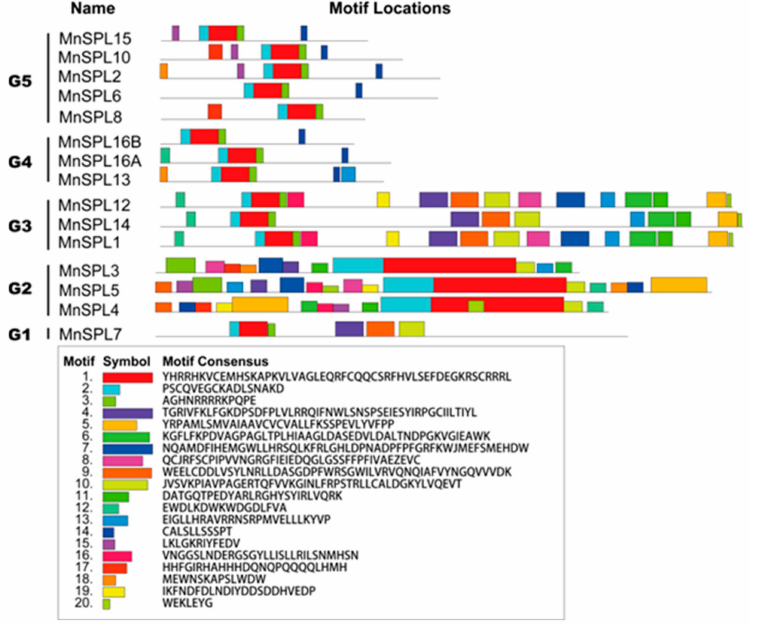
Figure 4. Distribution of putative conserved motifs in MnSPLs. The legend of the conserved motifs is shown below the graphic. Numbers 1–20 represent motifs 1–20, respectively. Box size indicates the length of